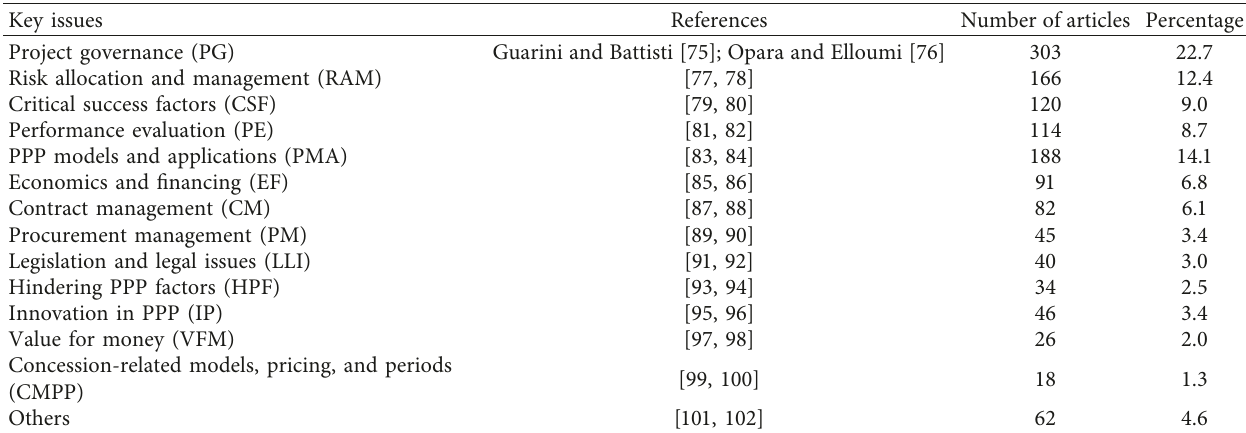
Figure 9: Frequencies of countries that have been studied in the literature sample. Table 10: Summary of key issues in the literature